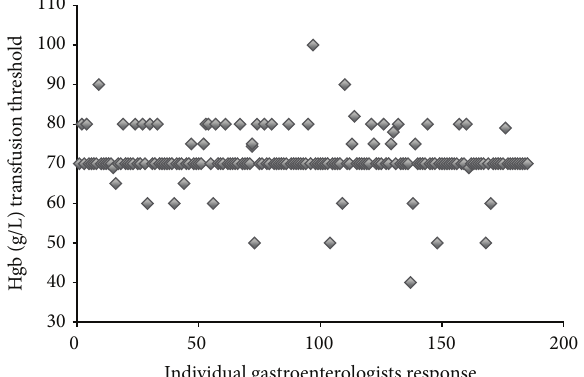
Figure 1: Selected hemoglobin transfusion thresholds for a healthy and hemodynamically stable patient with UGIB as described in Scenario 1. Each data point on the figure represents individual respondent’s transfusion threshold.